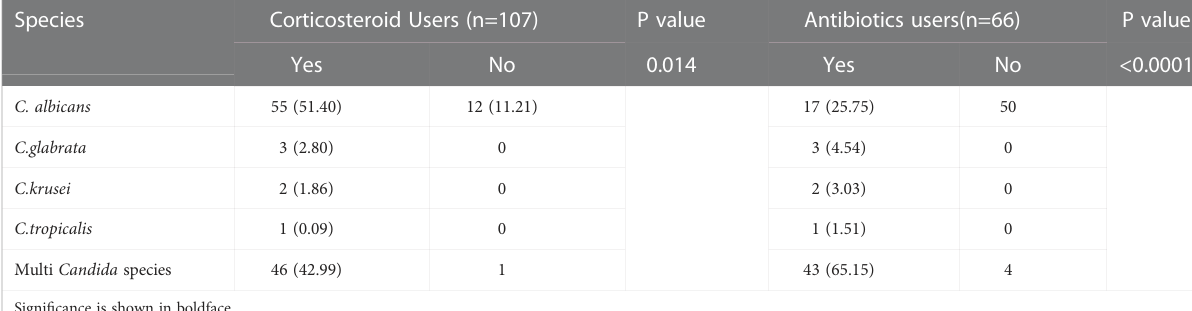
Signi fi cance is shown in